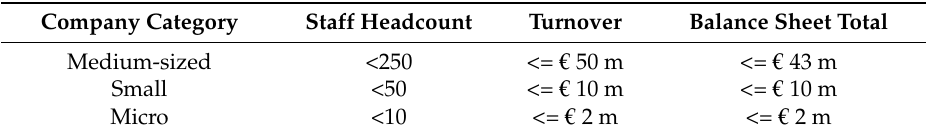
Table 4. Classification of companies (Source: Annex I of Regulation (EU) No. 651/2014 of the European Commission,